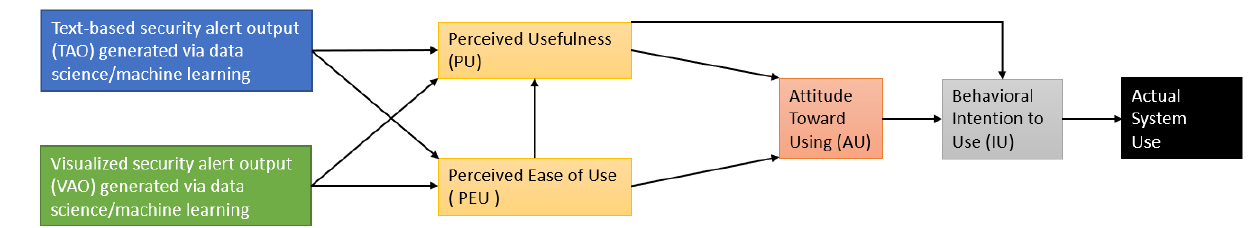
Figure 1. Theoretical Framework: Technology Acceptance Model. Adapted from “Perceived Usefulness, Perceived Ease of Use, and User Acceptance of Information Technology” [17].